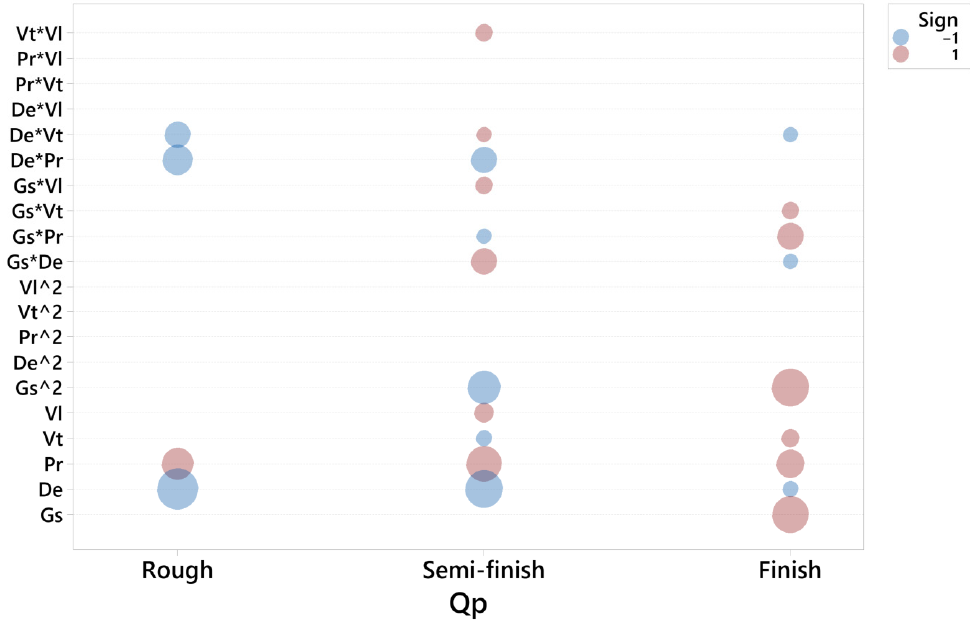
Figure 9. Significant terms for Qp in the rough, semi-finish and finish